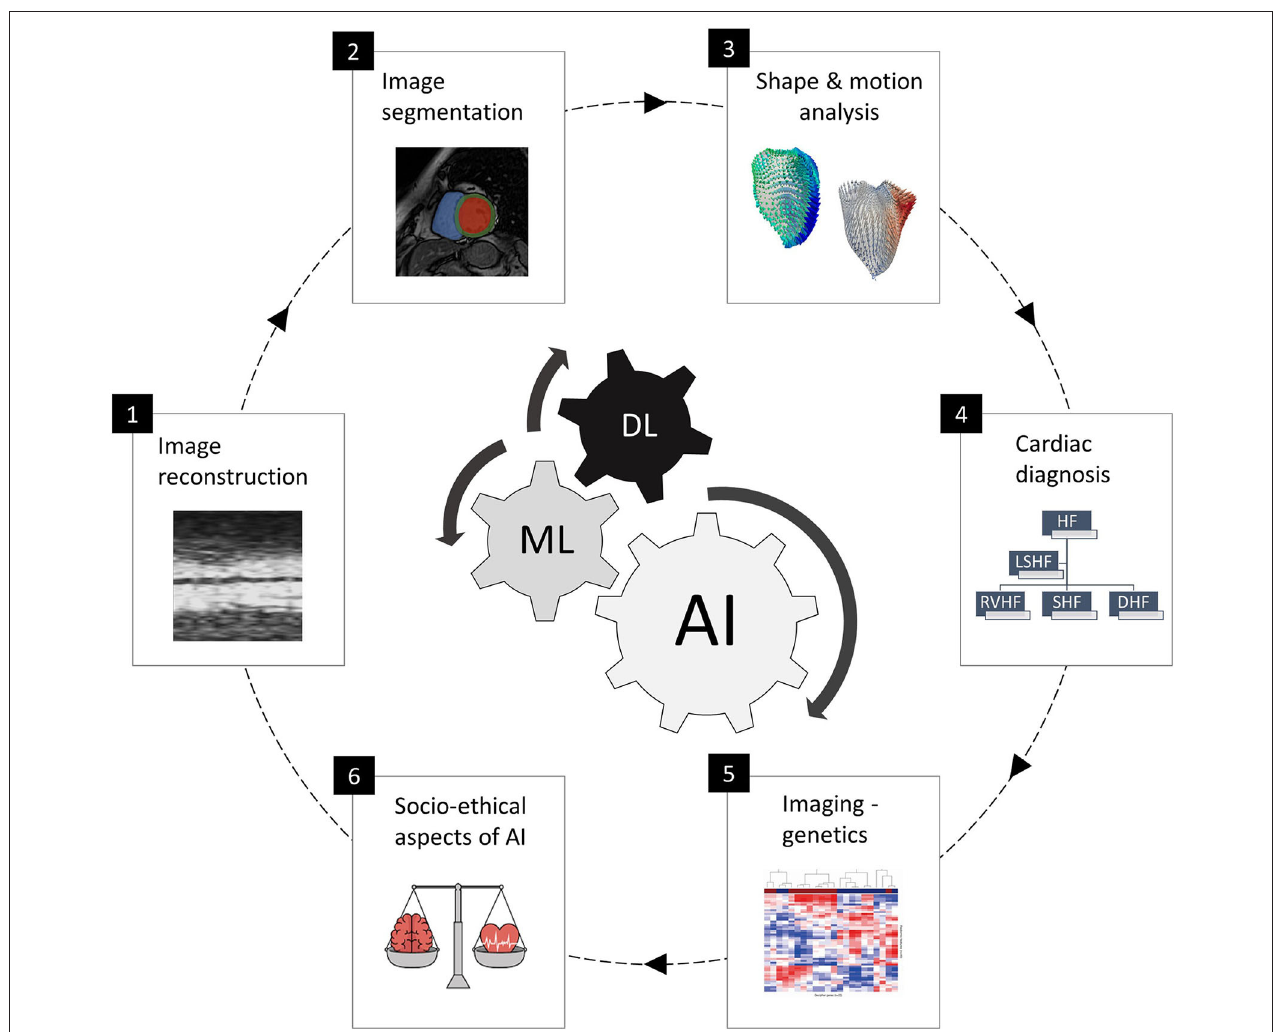
FIGURE 1 | The six areas of AI in cardiac imaging covered in this special issue, representing the full clinical workflow and including cardiac image acquisition and segmentation, shape and motion estimation, image-based cardiac diagnosis and imaging-genetics studies, as well as socio-ethical and regulatory aspects of AI. The subfigures are taken from the different papers in this special